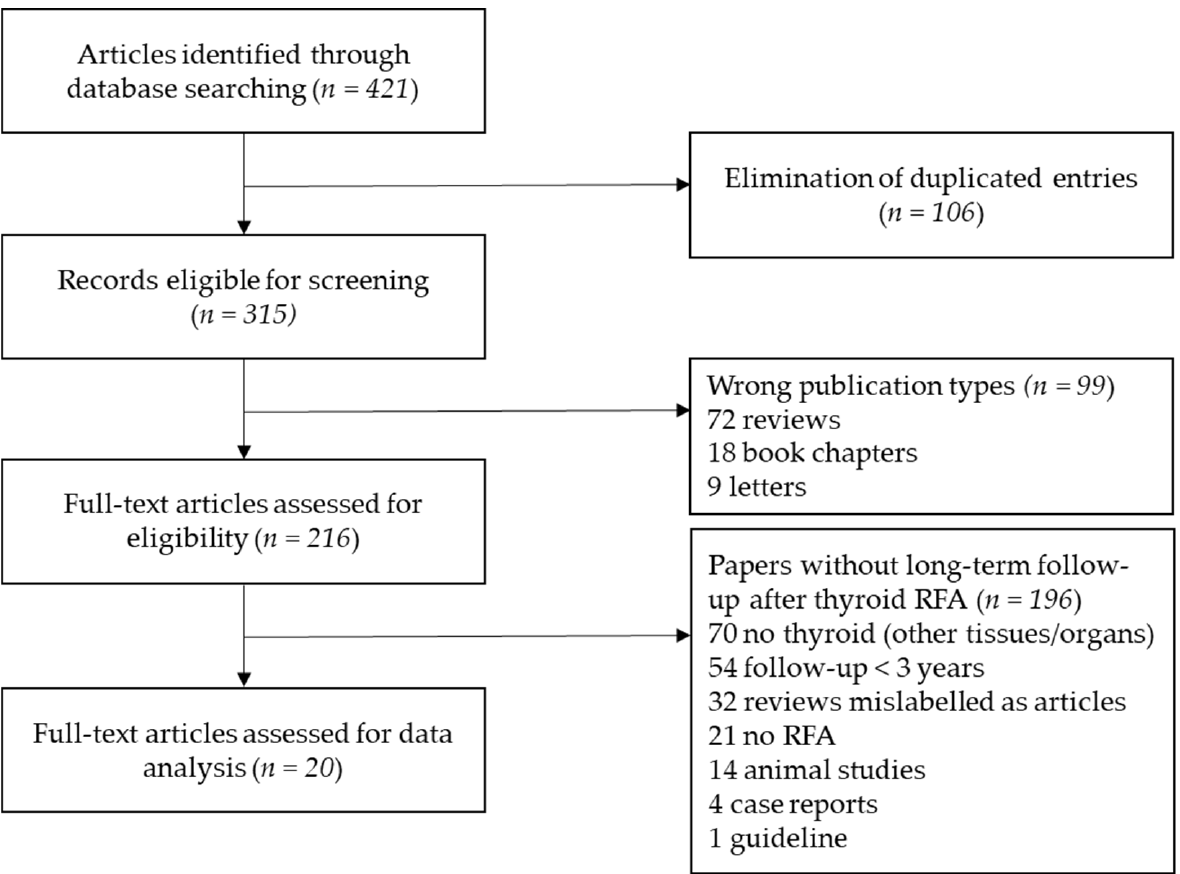
Figure 1. Stepwise procedure for study selection.